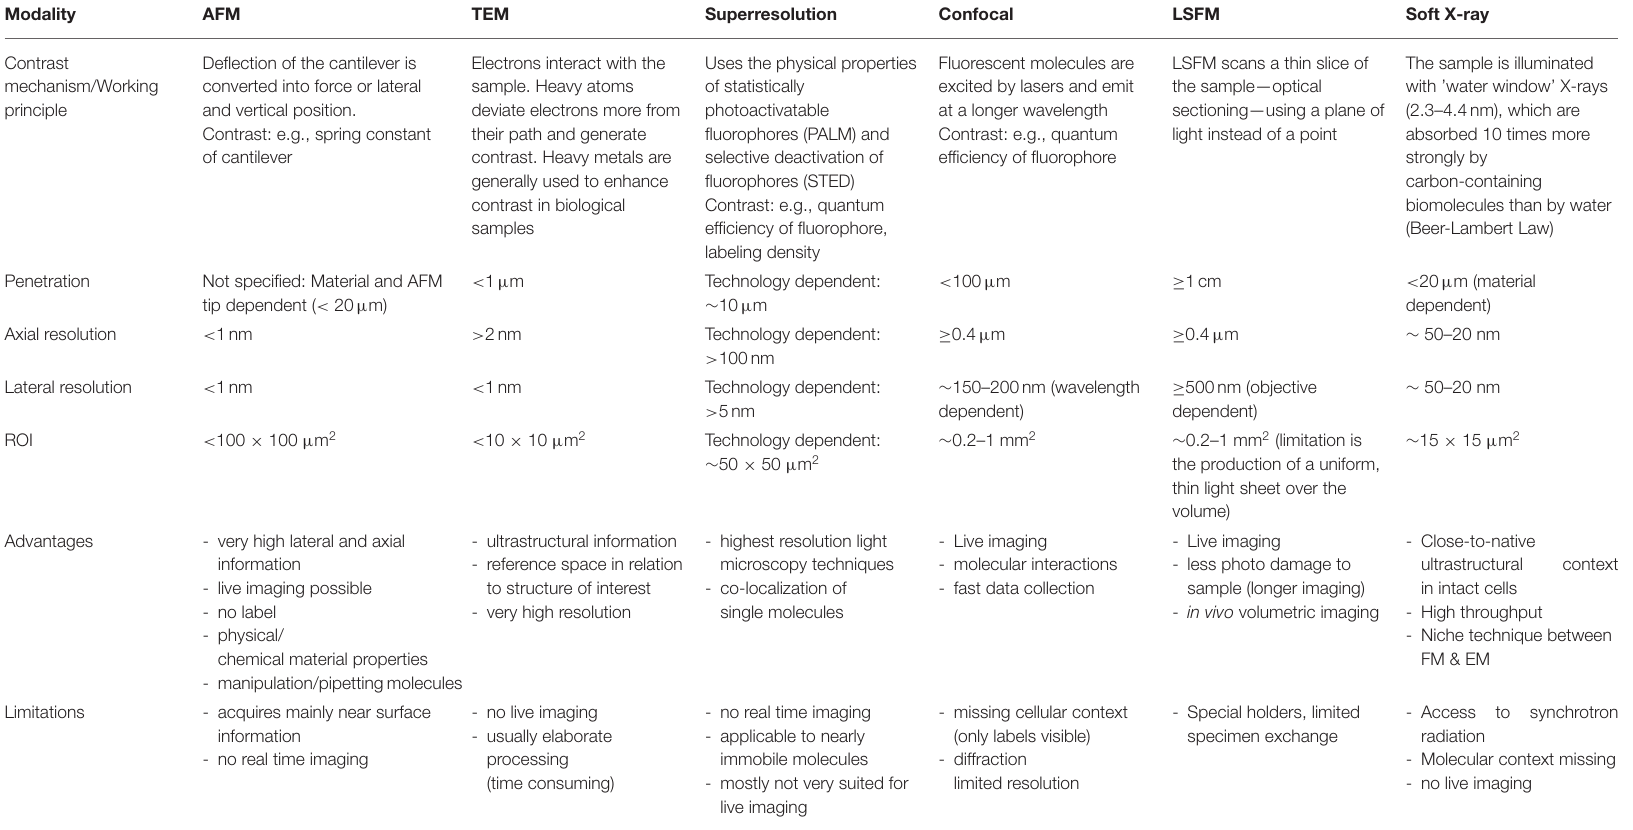
TABLE 3 | Imaging parameters, advantages, and limitations of the most used ex-vivo microscopy techniques in biological